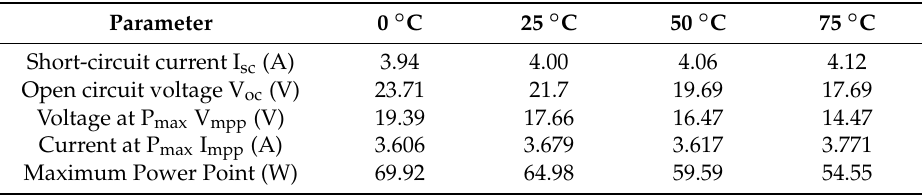
Table 3. Parameters of the PV module for variable temperature.